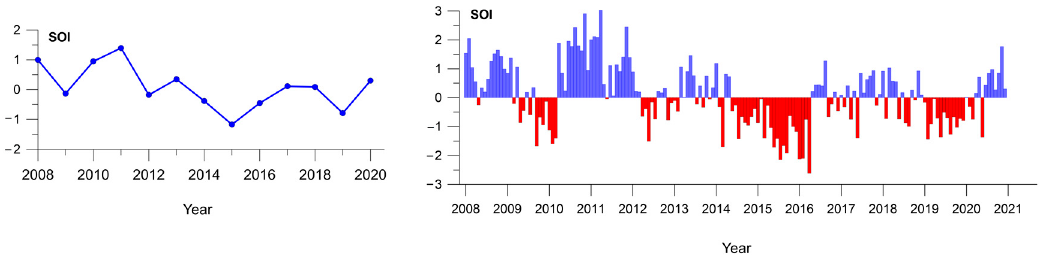
Figure 6. Yearly average SOI values ( left ) and monthly mean SOI values ( right ). El Niño phase is red, and La Niña phase is blue.